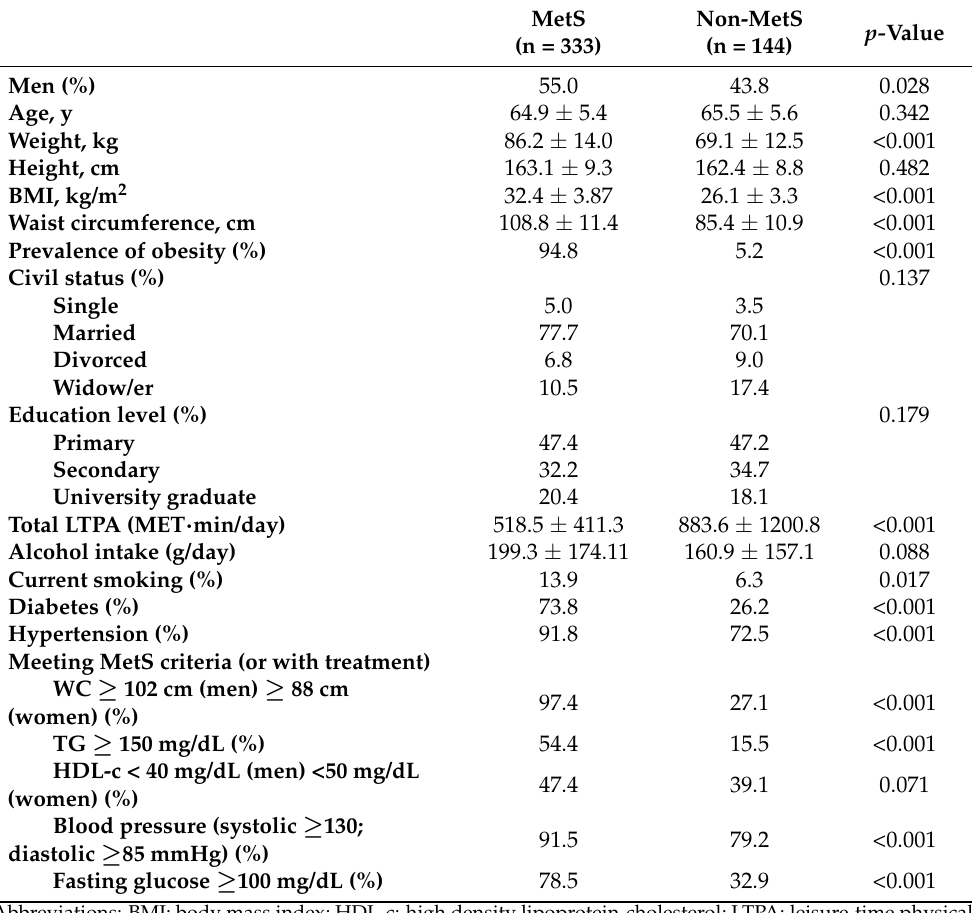
Table 1. Characteristics in older adults between MetS and non-MetS participants.